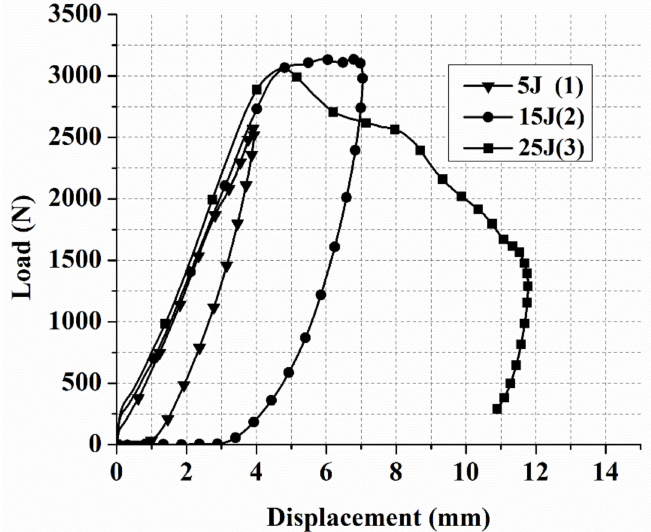
Figure 8. Load–displacement curves for low-velocity impact tests of laminate composites with [A/A] at 5, 15, and 25 J.